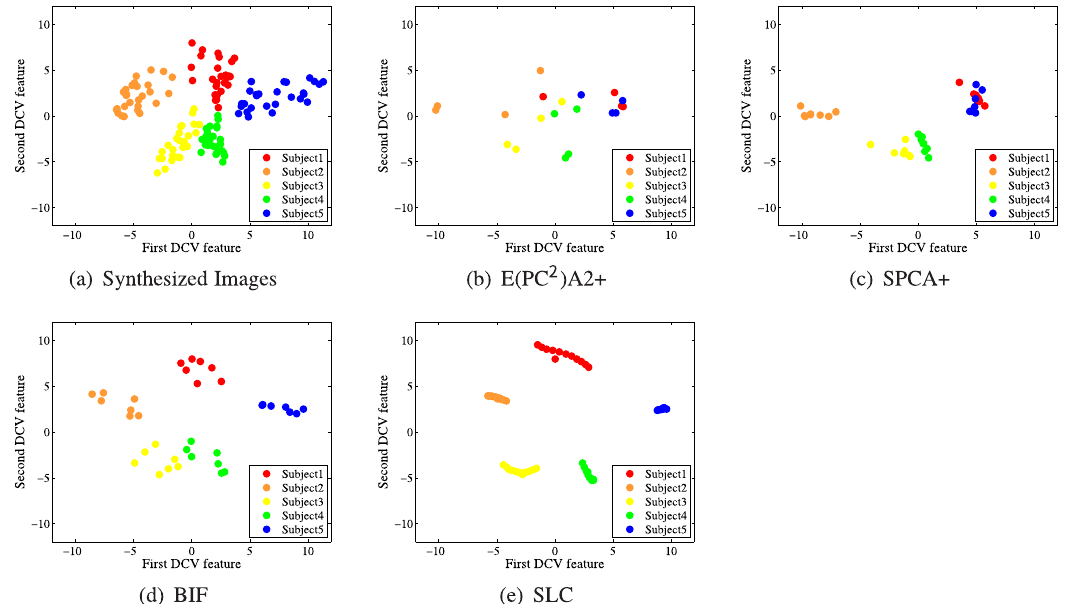
Figure 4. Distributions of image samples that were generated from a single image in the two-dimensional DCV (Discriminative Common Vector) feature space: ( a ) synthesized images (proposed method); ( b ) E(PC 2 )A2+; ( c ) SPCA+; ( d ) BIF; and ( e )